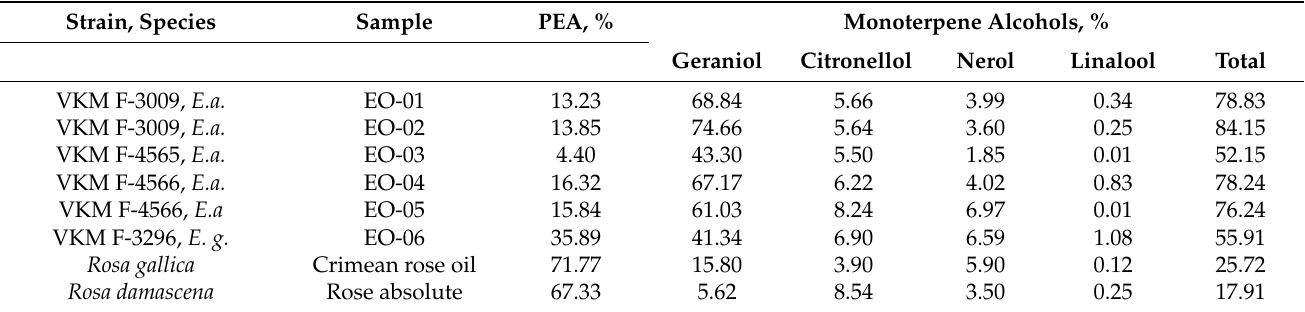
Table 1. Components of essential oils produced by E. ashbyi and E. gossypii (GS analysis).